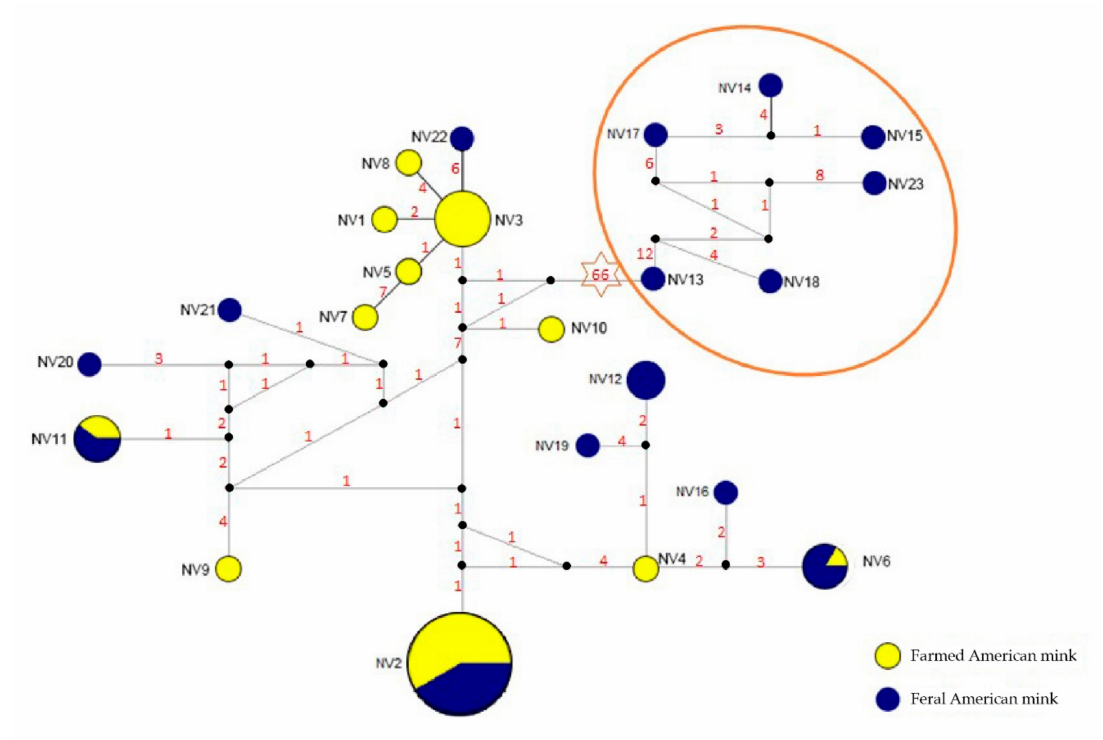
Figure 4. Median-joining network with node sizes proportional to the frequencies of farmed and feral mink haplotypes. The numbers of mutations separating the haplotypes are shown on the branches. The yellow colour represents the farmed mink, the blue colour represents the feral mink, and the small black dot indicates undetected haplotypes. One red area indicates the cluster of 6 feral